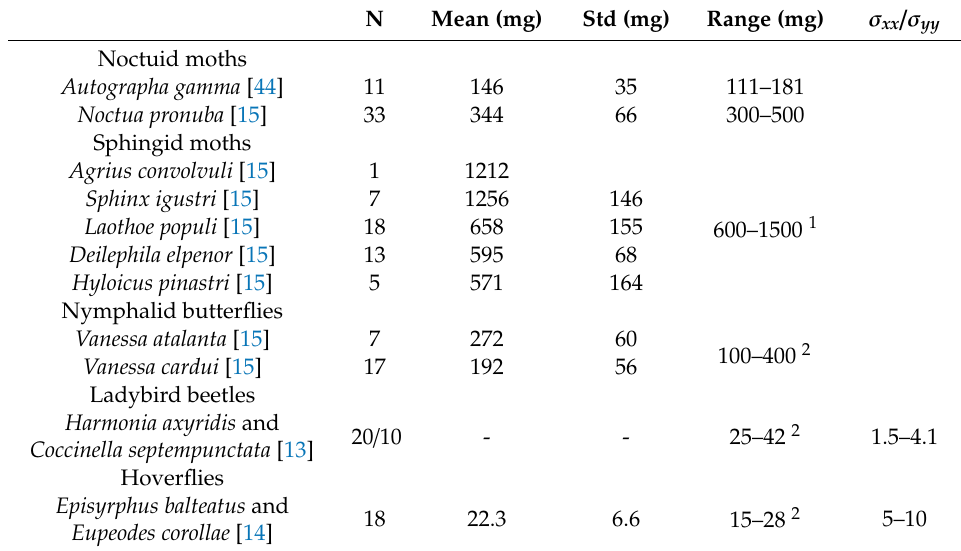
Table A1. Mass and radar cross section (RCS) measurements used to set target-selection criteria in previous radar studies.